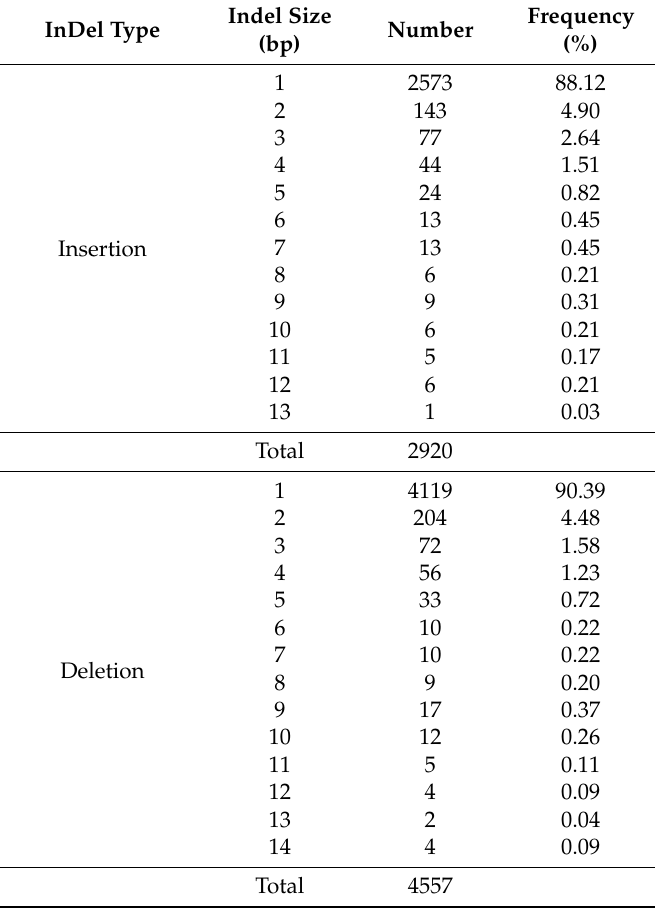
Table 1. The number of insertions-deletions (InDels) identified with double digest restriction site-associated DNA sequencing (ddRADSeq) analysis of 95 sesame accessions.